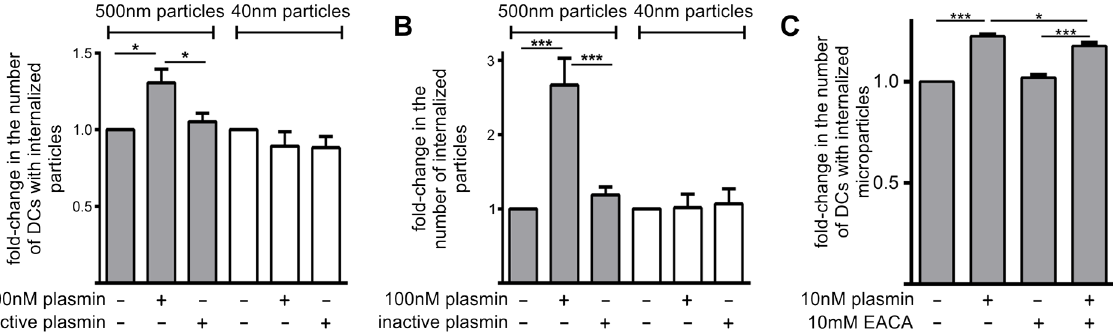
Fig 2. The proteolytic activity of plasmin increases the phagocytosis of microparticles, but not nanoparticles, by MoDCs. MoDCs were treated with 500 nm fluorescent microparticles or 40 nm fluorescent nanoparticles in the presence/absence of 100 nM active or inactive plasmin. 3 h later the relative number of particle-positive MoDCs (Panel A) and internalized particles (Panel B) were assessed by flow cytometry. Data shown are mean ± standard error (n = 3 – 4 independent experiments). Data were normalized to the groups where MoDCs received neither plasmin nor inactive plasmin. * p < 0.05 by 1-way ANOVA with Newman-Keuls post-hoc analysis. (C) MoDCs were treated with 500 nm fluorescent microparticles in the presence/absence of 10 nM active plasmin and/or 10 mM EACA. The relative number of particle-positive MoDCs was assessed by flow cytometry 24 h later. Data are displayed as mean fold- change in particle positive MoDCs ± s.e.m. (n = 4 independent experiments). Data was normalized to MoDCs receiving neither plasmin nor EACA. * p < 0.05, ** p < 0.01 and *** p < 0.001 by 1-way ANOVA with Newman-Keuls post-hoc analysis.